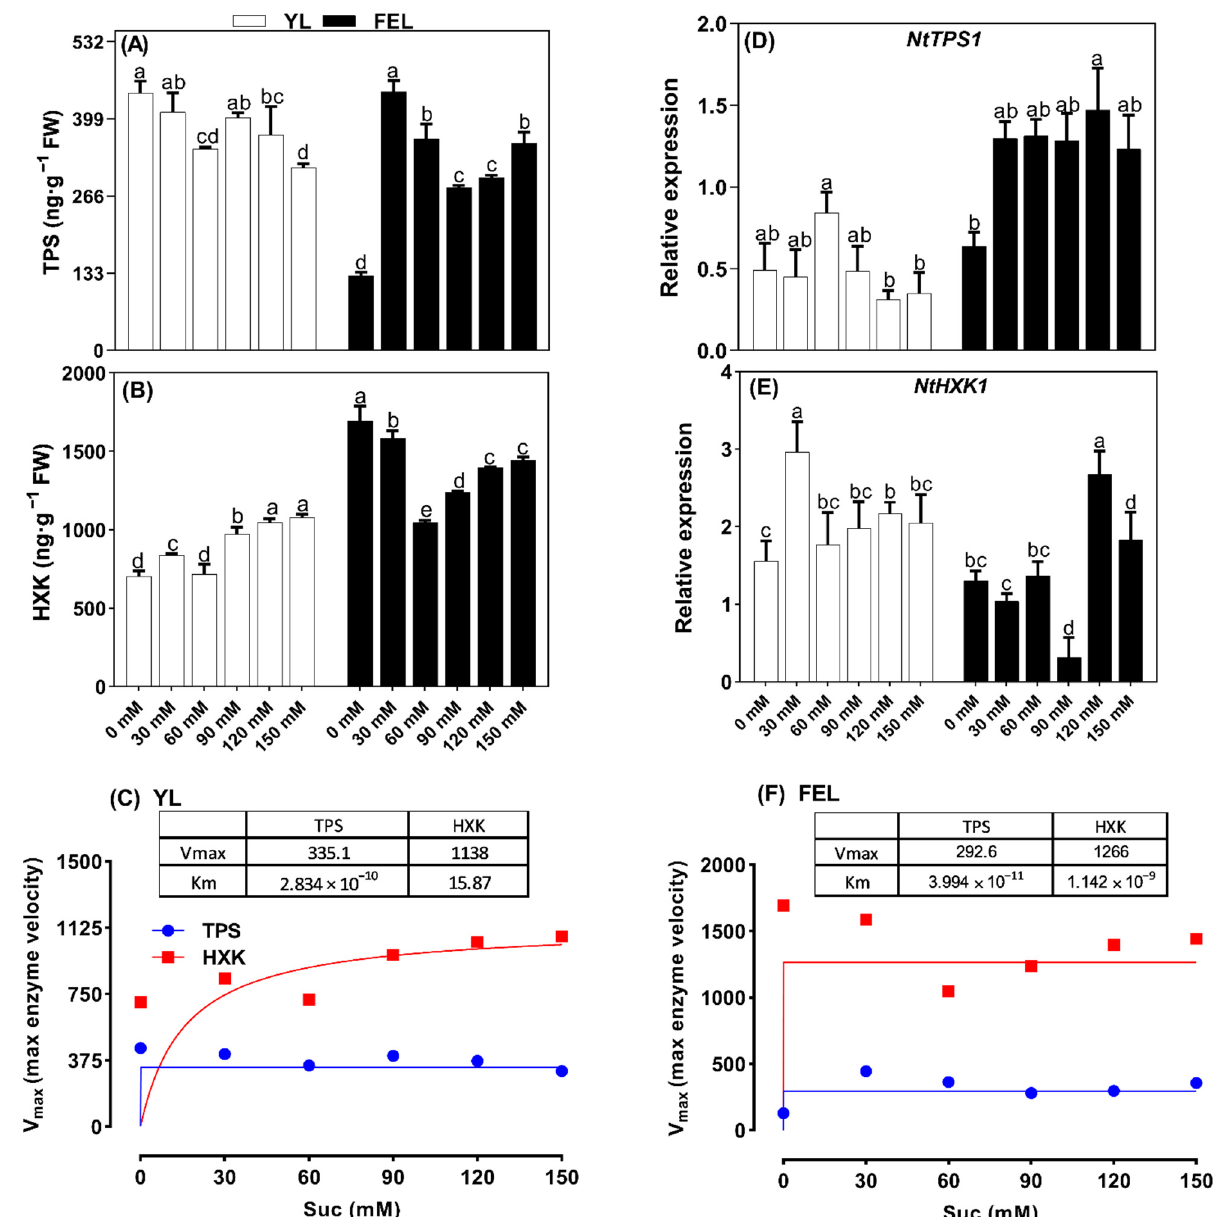
Figure 3. Dose-dependent effects of sucrose (Suc) on sugar metabolising enzymes. Trehalose